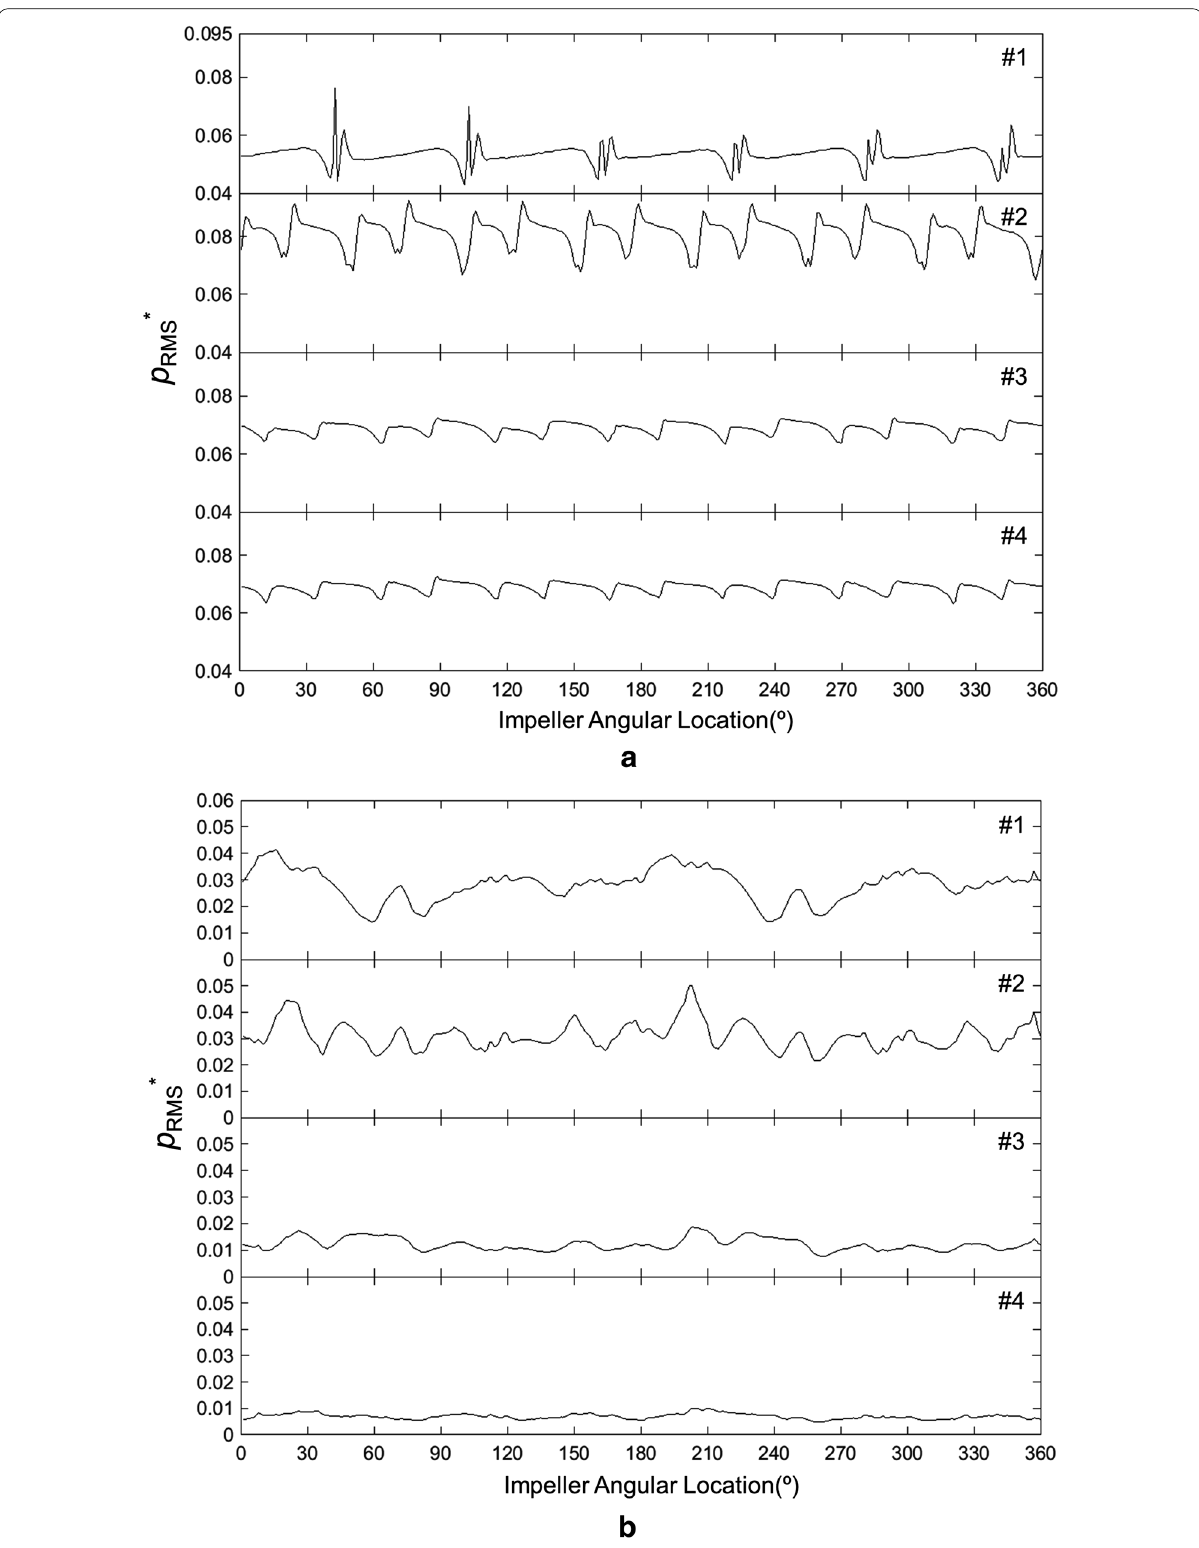
Figure 13 Dimensionless RMS pressure for the four models: a at a circle of 4 mm far from the impeller outlet diameter in the impeller; b at a circle with a diameter of 410 mm in the